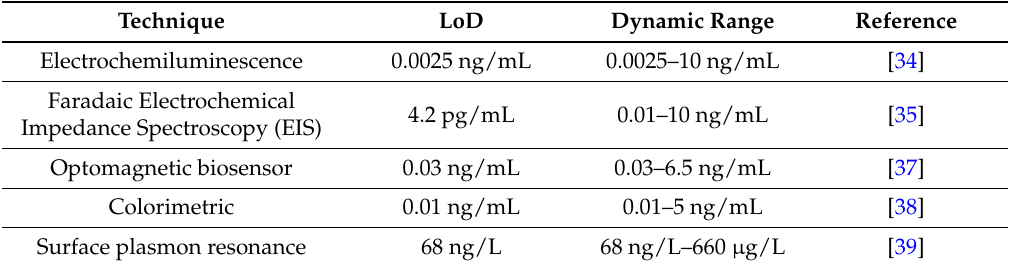
Table 1. Comparison of immunoassay performance for cTnI